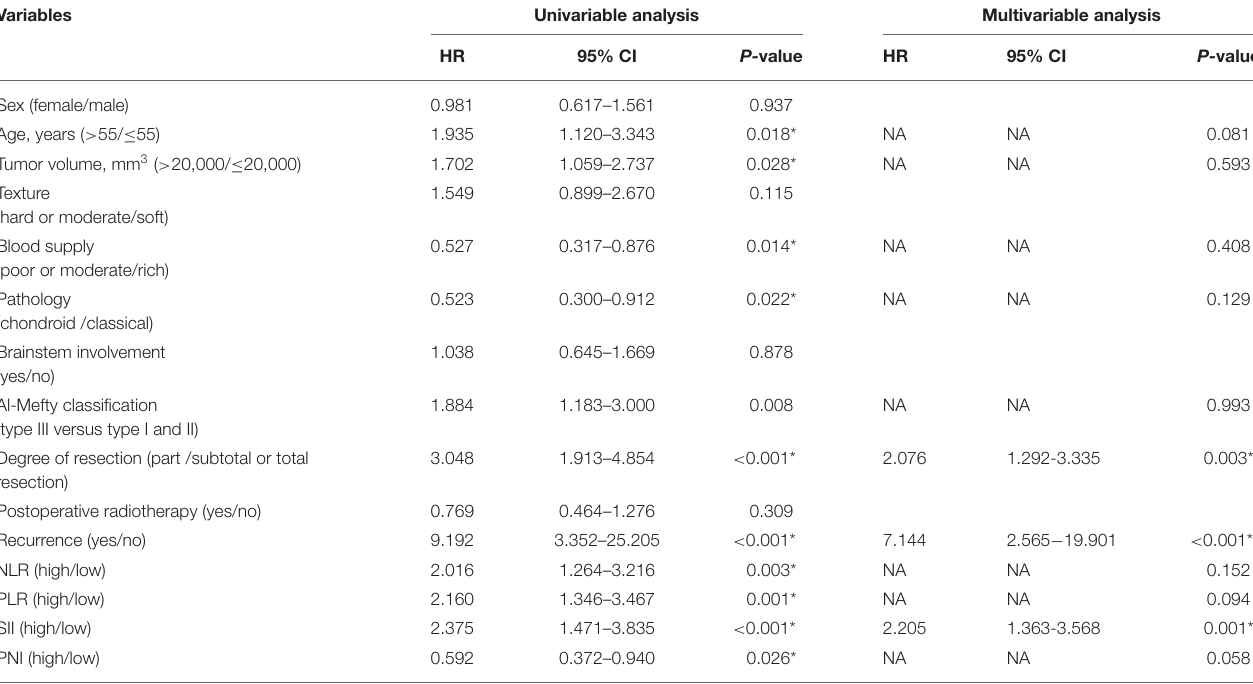
TABLE 2 | Univariable and multivariable cox analysis of overall survival in skull base